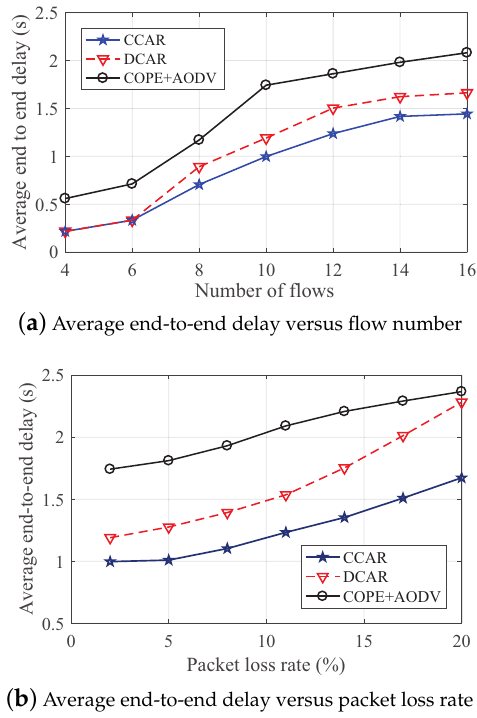
Figure 15. The impact on average end-to-end delay in the random